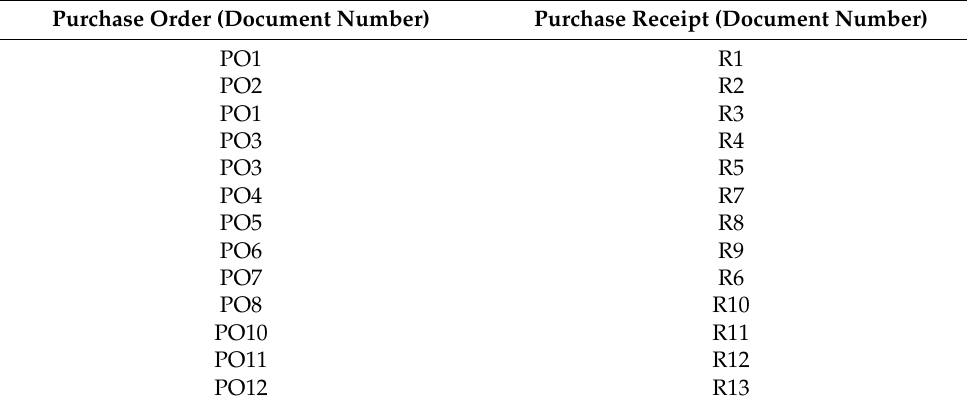
Table 3. Excerpt of the purchase item direct relation